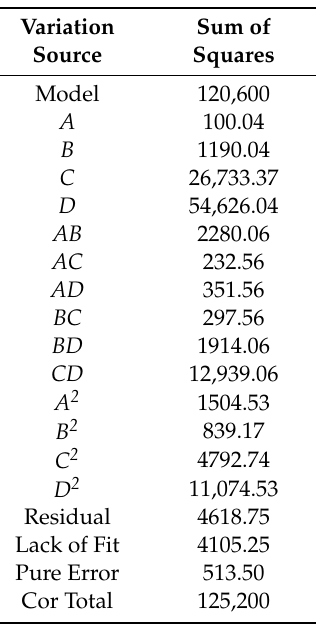
Table 6. Analysis of variance of the slump regression